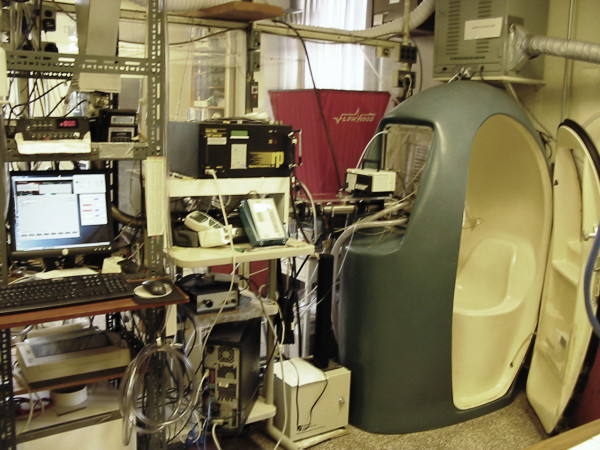
The photo of HEF with door open.